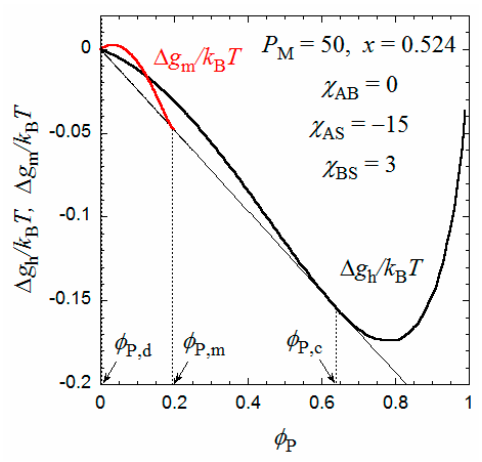
Figure 5. Concentration dependences of Δ g m and Δ g h at x = 0.524 calculated by Equations (9) and (10).